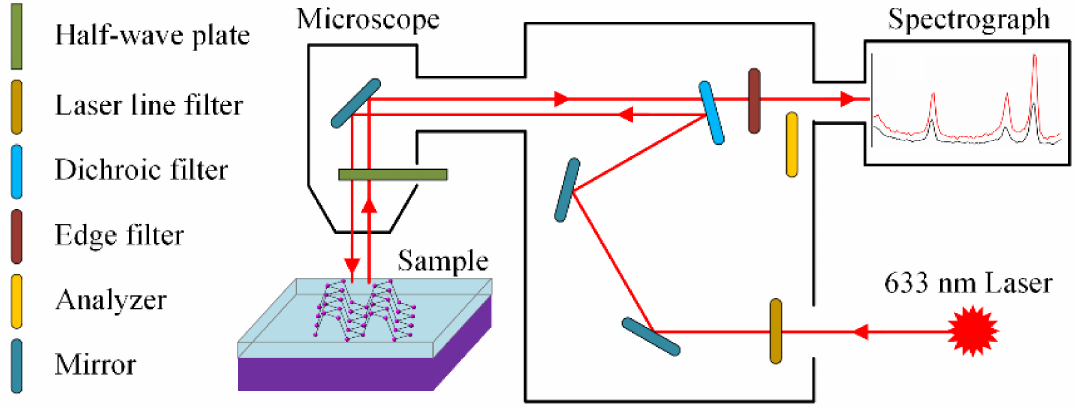
Figure 1. Diagram of polarized micro-Raman spectroscope.